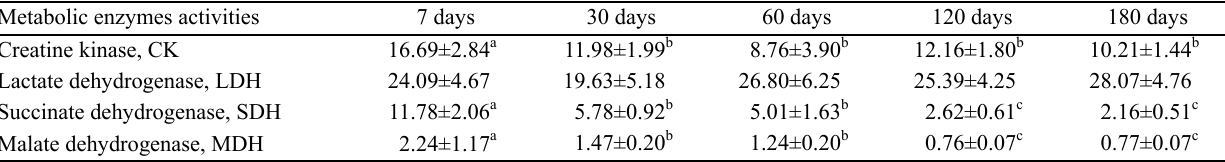
Table 4. Comparison of metabolic enzymes activities in LM of pigs with different postnatal ages Metabolic enzymes